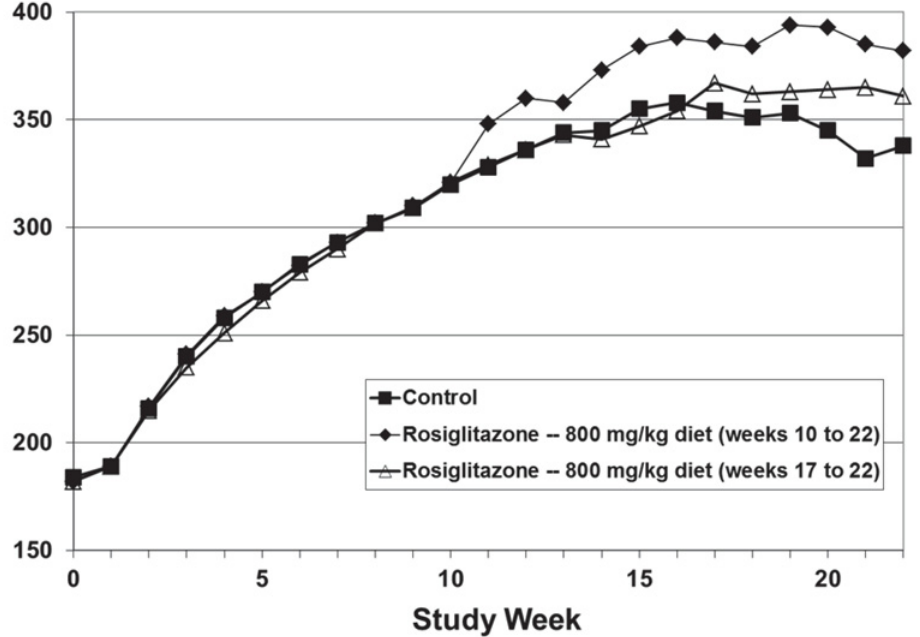
Fig 1. Influence of Rosiglitazone on Group Mean Body Weight in NQO-Treated Rats. Rosiglitazone (800 mg/kg diet) was administered to NQO-treated rats beginning either at week 10 (1 day after completion of NQO administration) or at week 17 (7 weeks after completion of NQO administration; late administration group). In comparison to the NQO-treated control group, statistically significant increases in group mean body weight were seen in rosiglitazone-treated rats at the following times: 800 mg rosiglitazone per kg diet group, weeks 11, 12, and 14 through 22; 800 mg rosiglitazone per kg diet (late) group, week 21